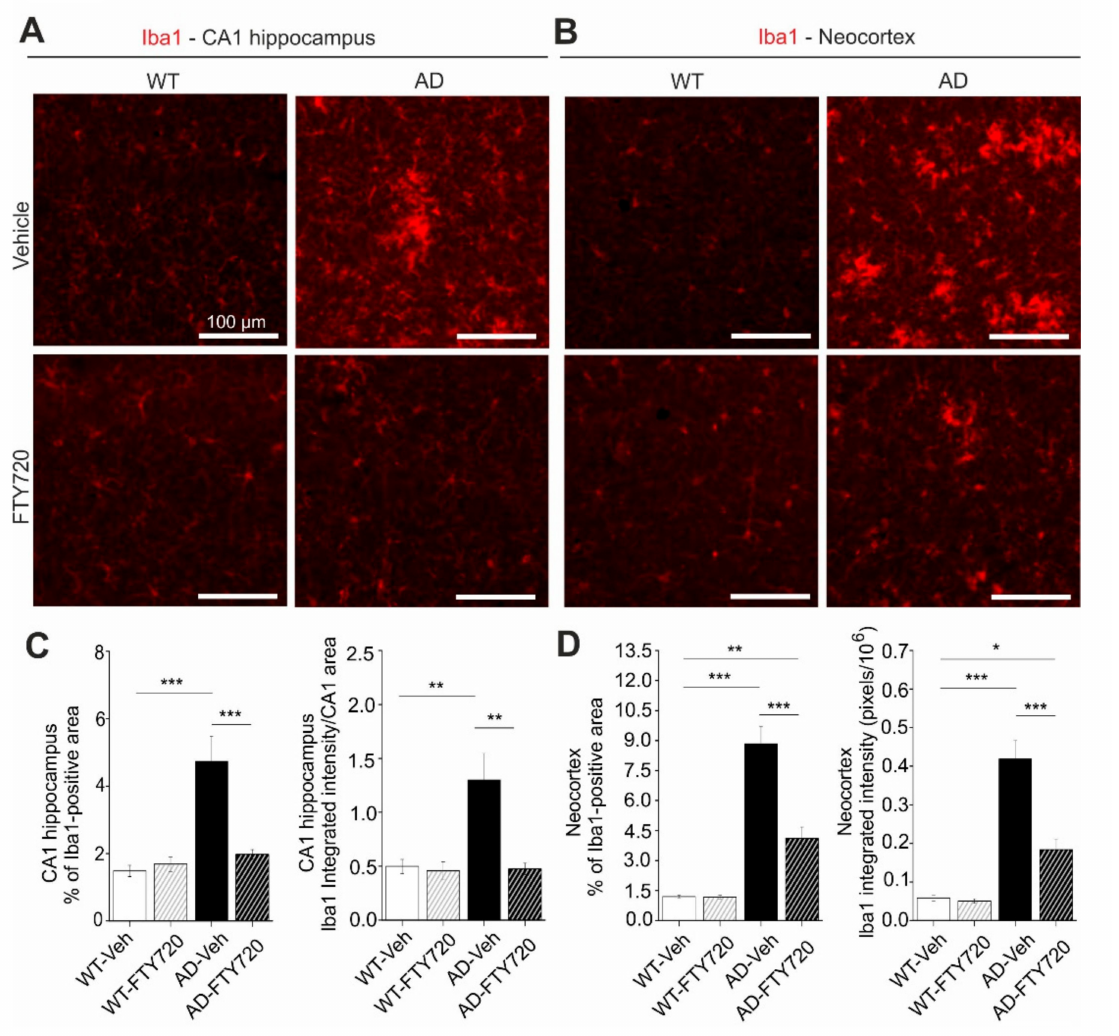
Figure 4. Chronic fingolimod (FTY720) treatment reduces microgliosis in hippocampus and neocortex of APP / PS1 mice. Five- to six month-old male WT and APP / PS1 mice were treated with i. p . injections of fingolimod for one to two months. Ionized calcium-binding adapter molecule 1 (Iba1) immunohistochemistry was performed in the hippocampal CA1 area ( A , C ) and in the neocortex ( B , D ) at six to seven months. ( A ) Iba1 expression was detected with a red fluorescent secondary